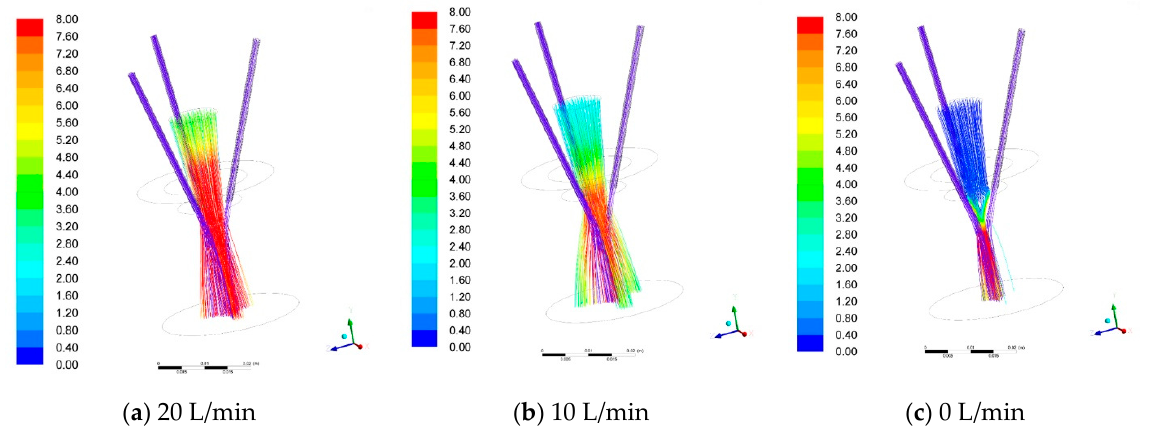
Figure 11. Influence of inner shielding gas on carrier gas. ( a ) 20 L/min; ( b ) 10 L/min; ( c ) 0 L/min.